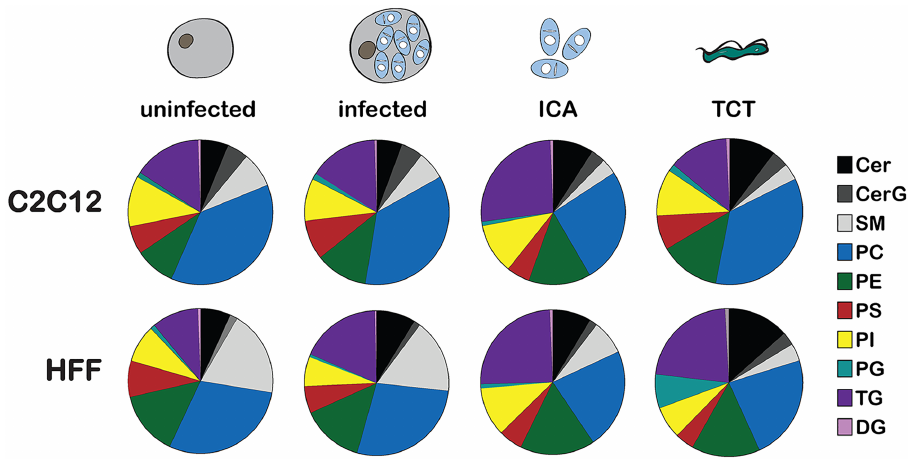
Fig 2. Lipid class breakdown in T . cruzi and mammalian cells. Pie charts display the relative abundance of the major lipid subclasses of mammalian host cells (C2C12 and HFF) and T . cruzi intracellular amastigotes (ICA) and tissue- culture trypomastigotes (TCT) represented as a portion of total lipid content in each sample, averaged for 4 independent experiments. TG–triacylglycerol, DG–diacylglycerol, Cer–ceramide, CerG–hexosylceramide, SM– sphingomyelin, PC–phosphatidylcholine, PE–phosphatidylethanolamine, PS–phosphatidylserine, PI– phosphatidylinositol, PG–phosphatidylglycerol.